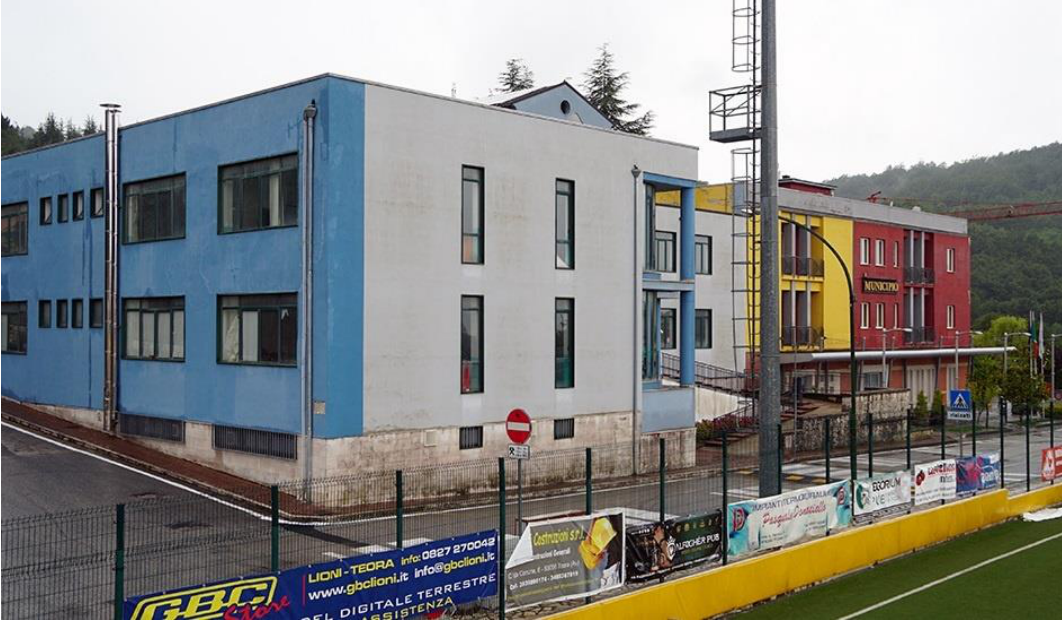
Figure 101. Teora: the new Church of S. Nicola di Mira (photos by [35,36]).